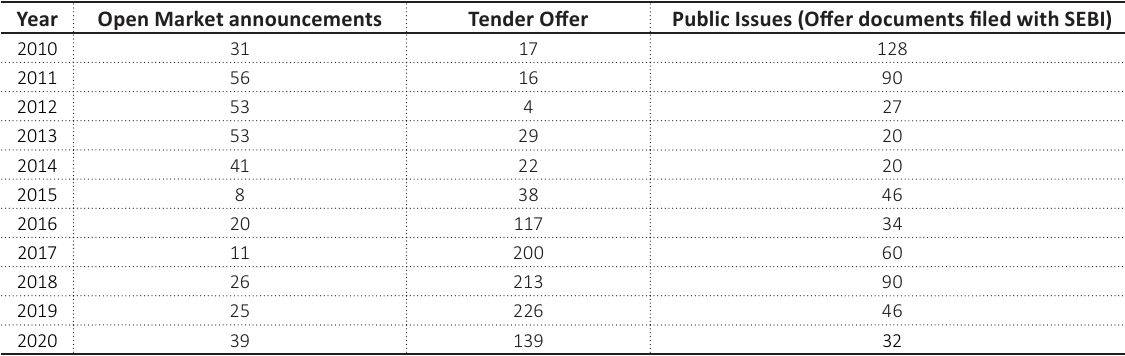
Table 5. Number of open market offers, tender offers and IPOs